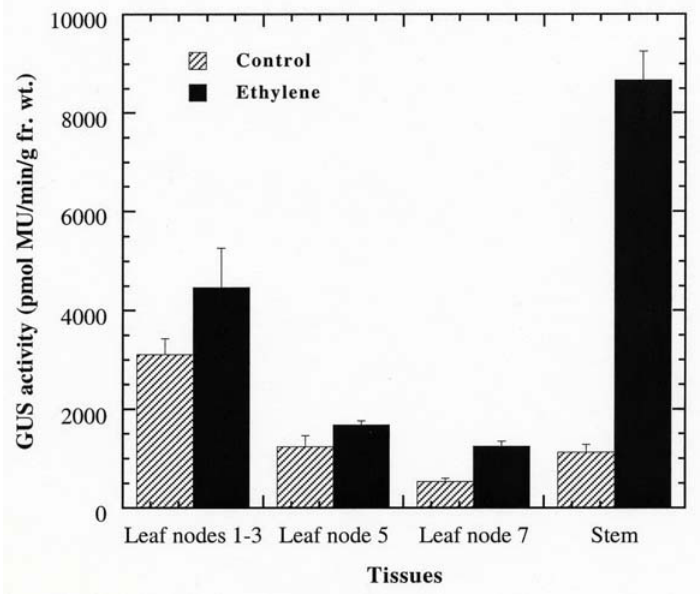
Figure 4. Responsiveness of PPO B to ethylene. BxG shoots were incubated in 1 mM ethephon in NaPO4 buffer, or in NaPO4 buffer alone (control). After 48 h, apical leaf nodes 1 to 3, leaf nodes 5 and 7, and the stems at internodes 7 and 8 were collected